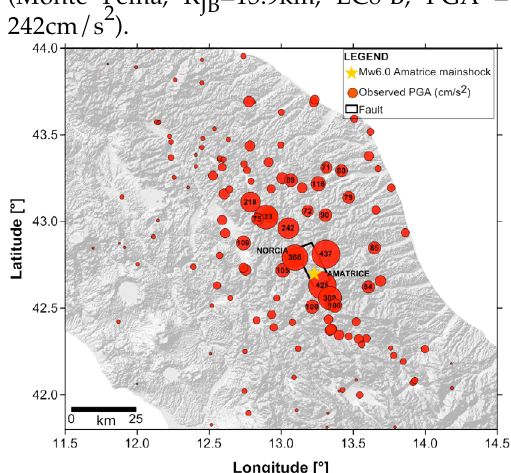
Figure 2 . Spatial distribution of the maximum horizontal Peak Ground Acceleration (cm/s 2 ).